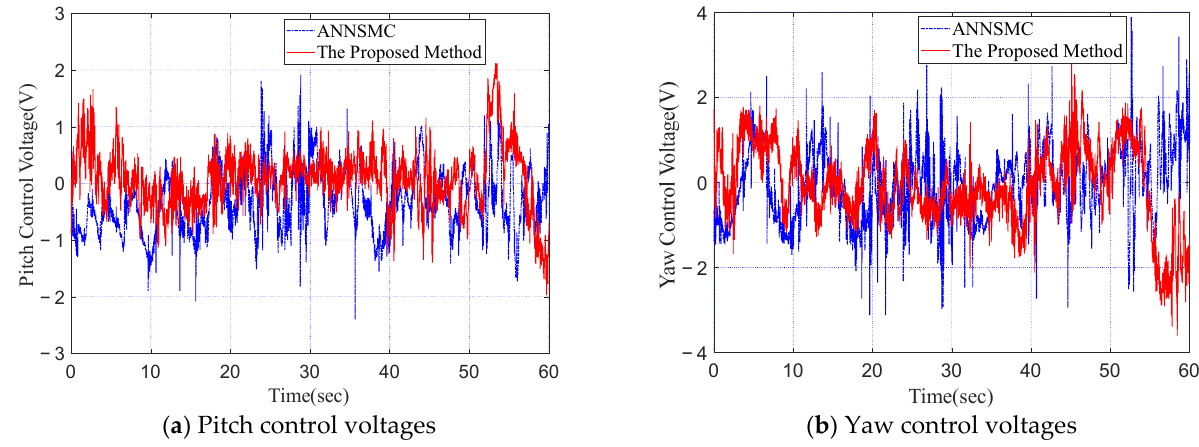
Figure 9. The control voltages of the two controllers in Case 1.